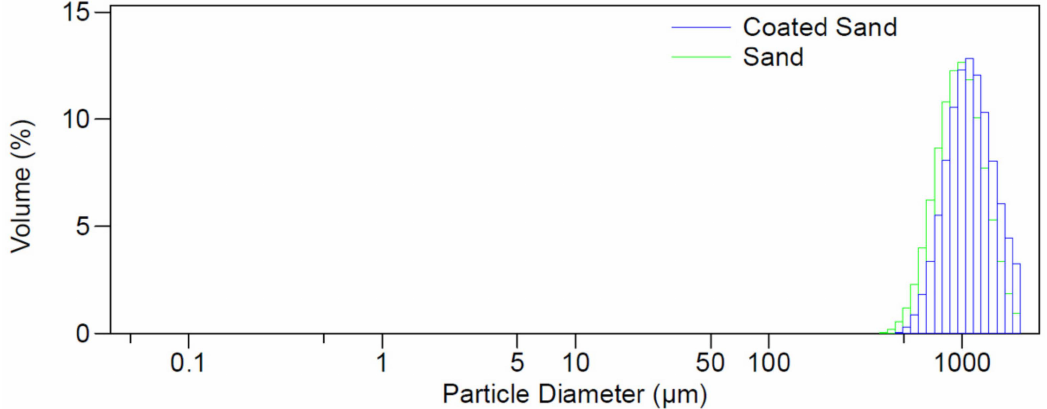
Figure 9. Particle size distribution for sand and coated